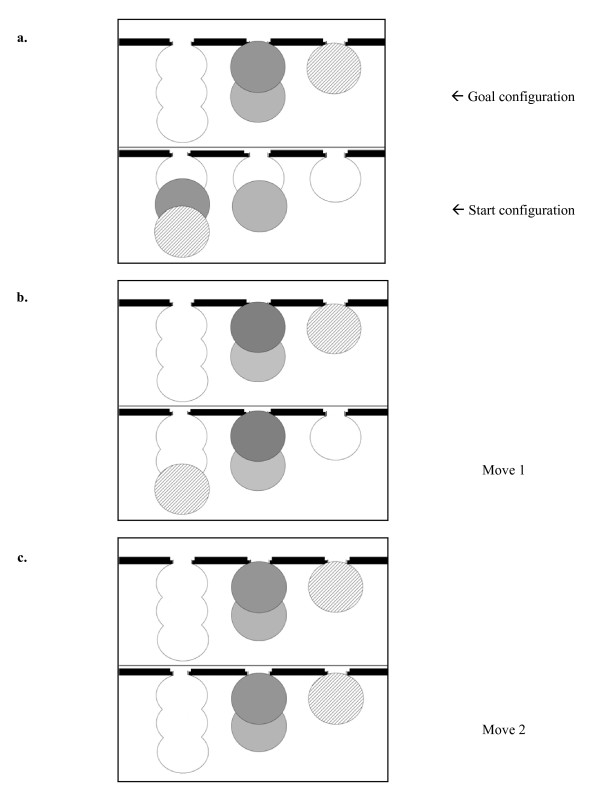
Stockings of Cambridge. Schematic illustration of a 2-move problem, with start configuration (a.), move 1 (b.) and move 2 (c.). Note: grey shades and hatching instead of colours.